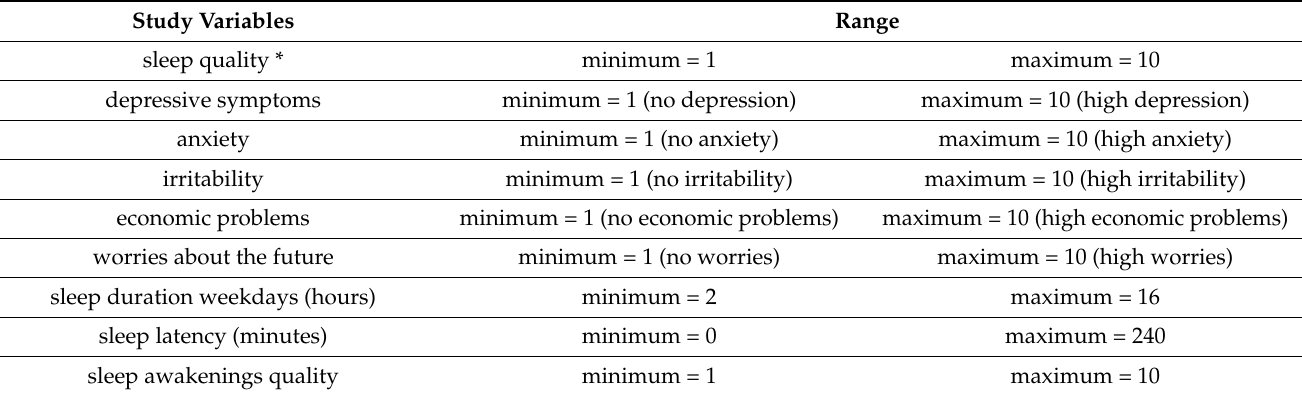
Table 2. Variable descriptions included in the study ( n =